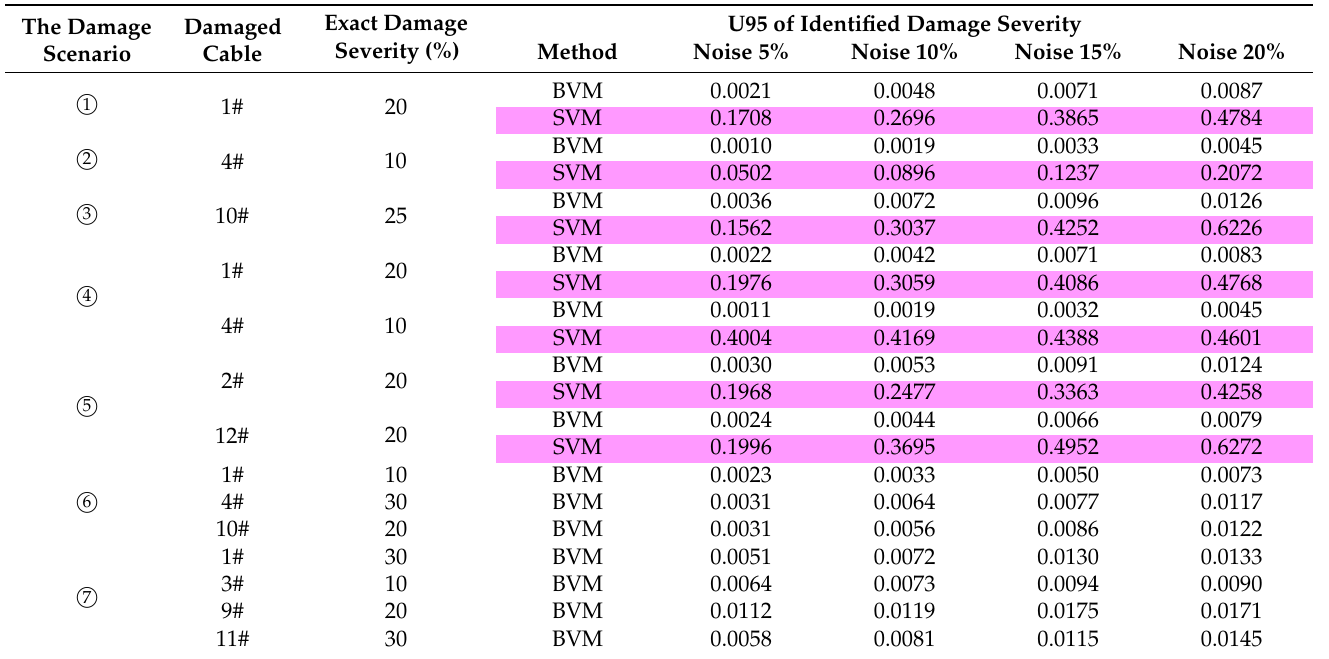
Table 9. The U95 of the identified damaged severity of the 7 damage scenarios’ test dataset using the BVM method and the SVM method